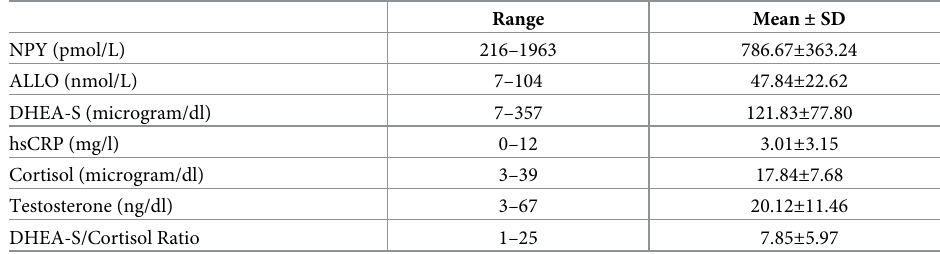
Table 2. Descriptive statistics for biochemical